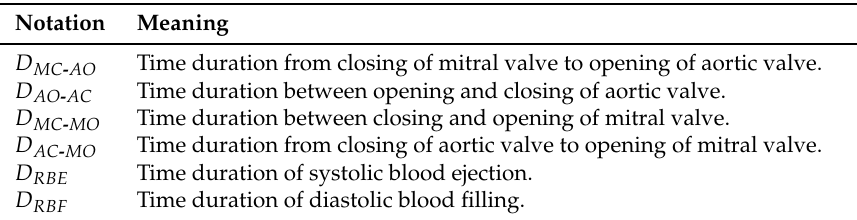
Table 2. Notation and meaning of SCG